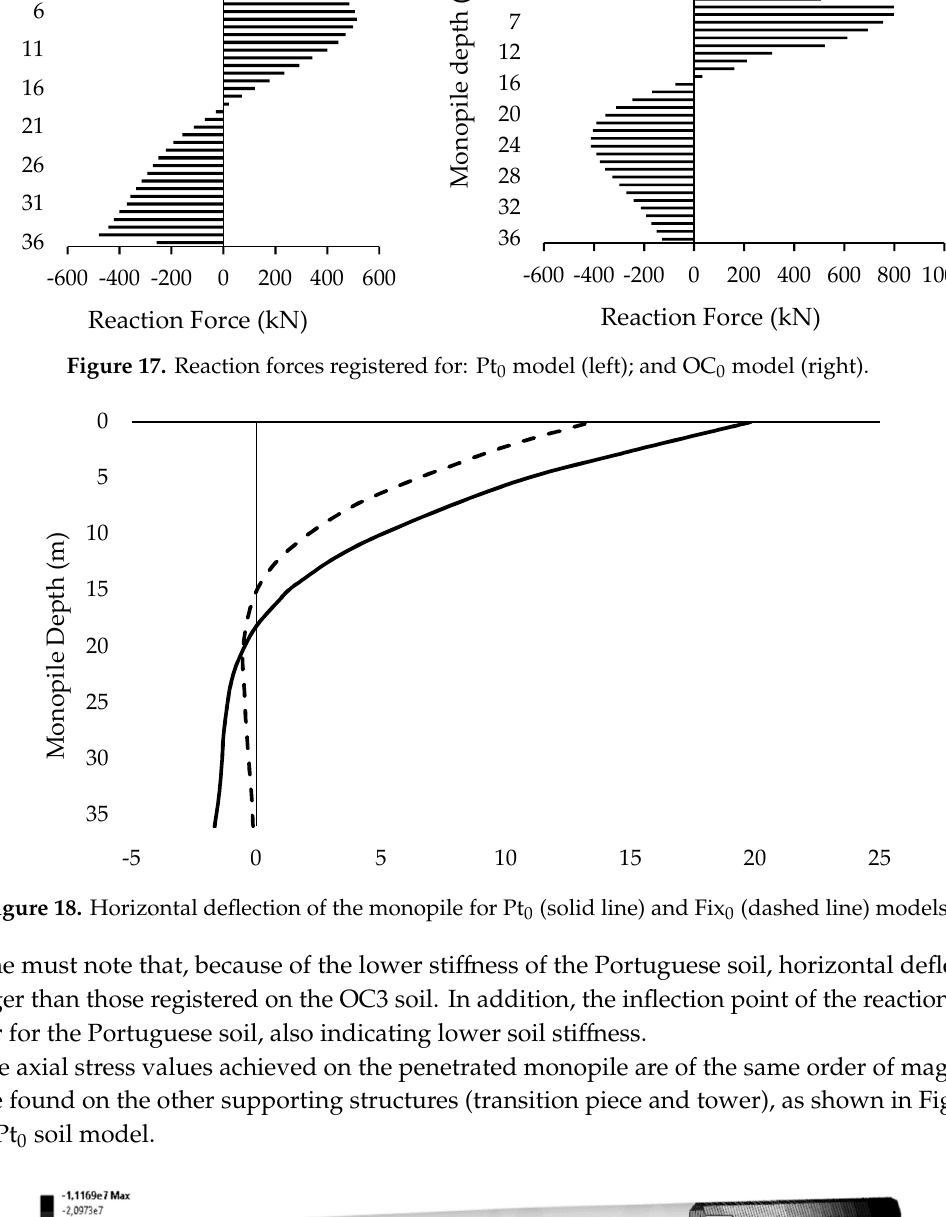
Figure 18. Horizontal deflection of the monopile for Pt 0 (solid line) and Fix 0 (dashed line) models.